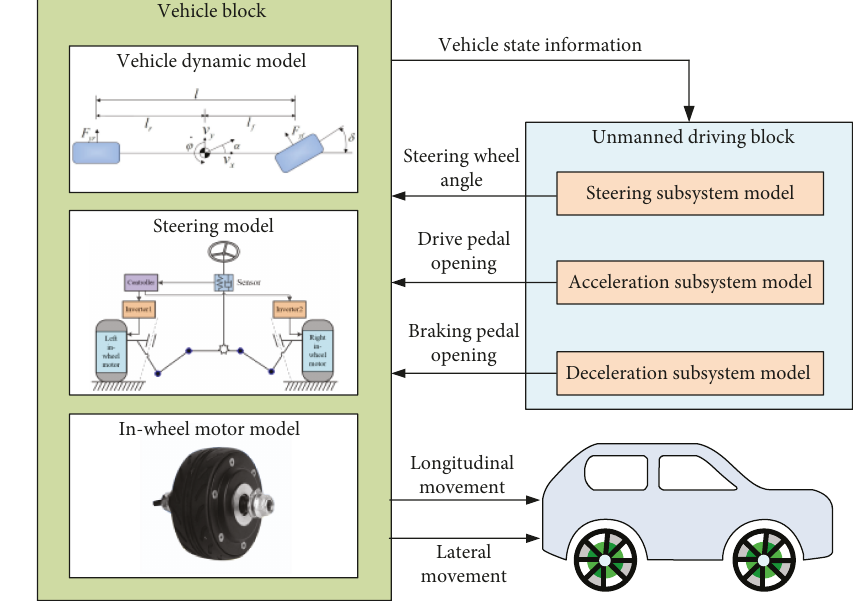
Figure 2: The dynamic model diagram of unmanned driving IWM-EV.